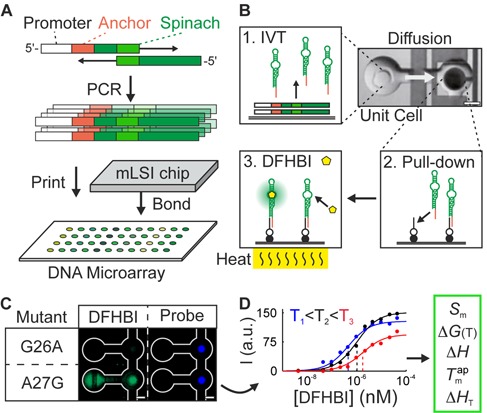
The experimental workflow to determine binding and stability landscapes of fluorescent RNA aptamers. (A) A DNA mutant library was created by stitch PCR. DNA sequences encoding of the single- and double-point Spinach mutants were spotted on a glass microarray and bonded to a microfluidic polydimethylsiloxane (PDMS) chip. (B) On the chip, the DNA transcription (1), a miniaturized pull-down assay (2), and a perfusion system (3) for 640 RNA mutants were automated in separate microfluidic unit cells. The chip was mounted on a thin glass coated with indium tin oxide (ITO) for control of the temperature on the glass surface. (C) Fluorescent signals of two Spinach mutants in the pull-down area of a chip unit cell. The total amount of RNA in the pull-down area was quantified with a probe molecule. (D) The binding and melting curves were used to calculate the free energy (ΔG), and enthalpy (ΔH) of the binding, the apparent melting temperature of the RNA–DFHBI complex (\documentclass[12pt]{minimal}
\usepackage{amsmath}
\usepackage{wasysym} 
\usepackage{amsfonts} 
\usepackage{amssymb} 
\usepackage{amsbsy}
\usepackage{upgreek}
\usepackage{mathrsfs}
\setlength{\oddsidemargin}{-69pt}
\begin{document}
}{}$T_m^{ap}$\end{document}), and the fluorescence intensity of the Spinach complexes (S) with 3,5-difluoro-4-hydroxybenzylidene imidazolinone (DFHBI).